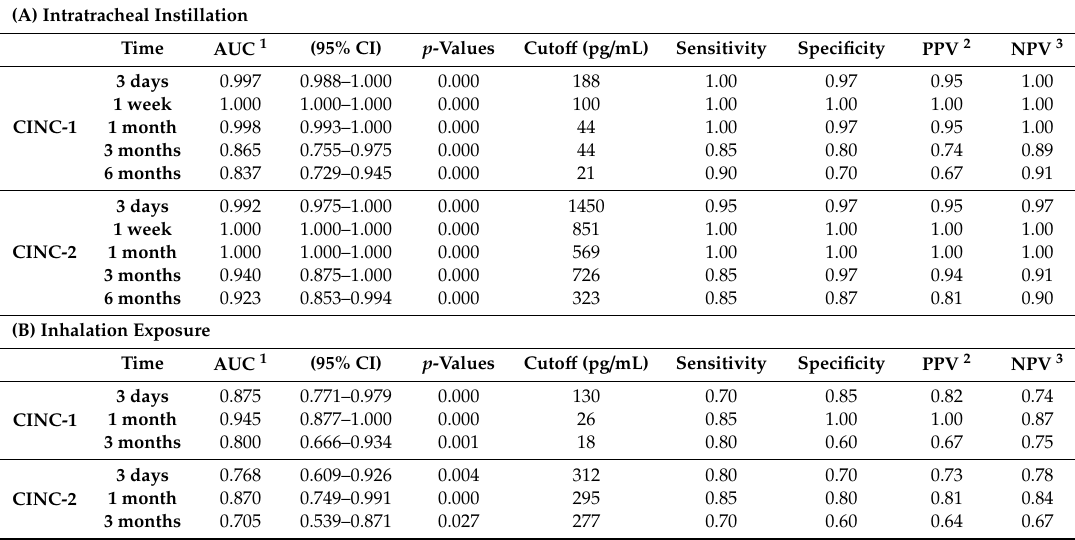
Table 2. Results of receiver operating characteristics (ROC) analysis in intratracheal instillation and inhalation exposure of NMs.